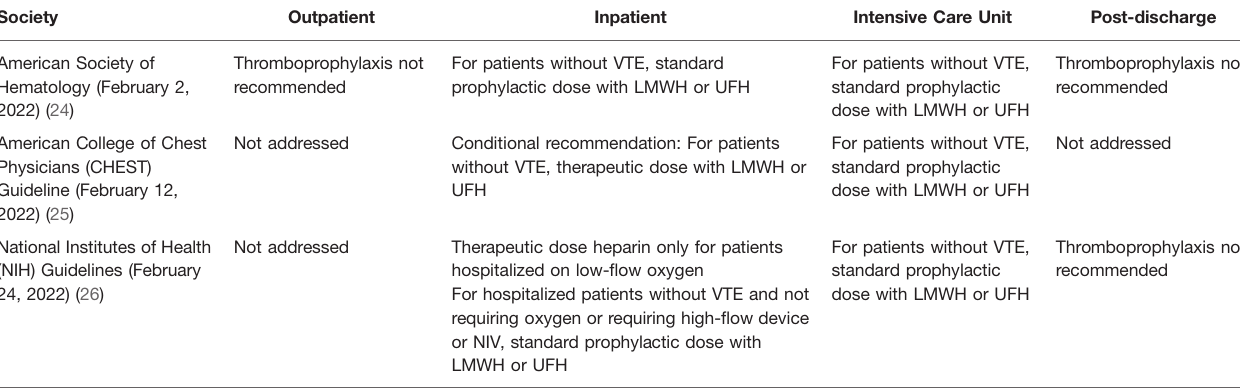
Abbreviations: LMWH, low molecular weight heparin; UFH, unfractionated heparin; VTE, venous